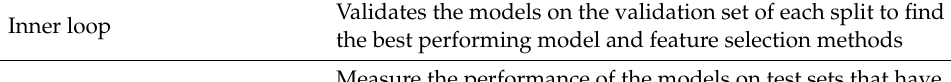
Table 3. Description of inner and outer loops of the employed cross-validation in this study.